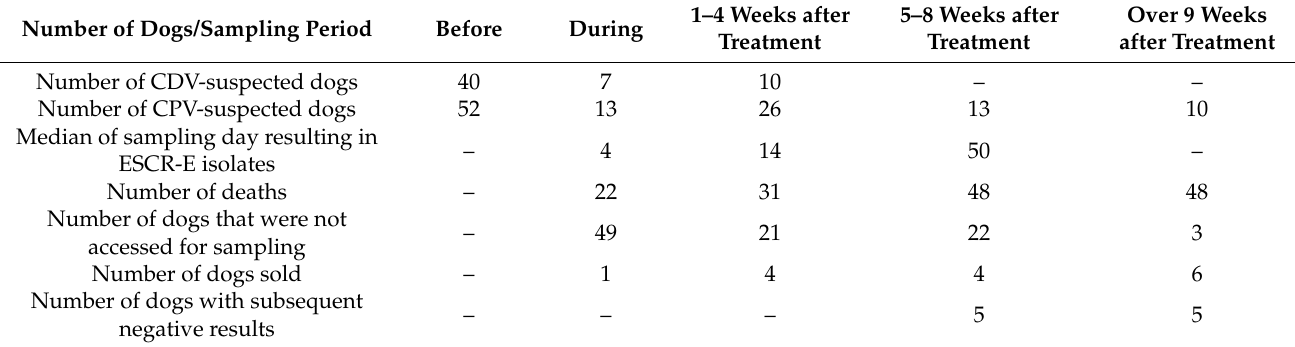
Table 3. Design and sample size of our longitudinal study tracking ESCR-E before and after antibiotic treatment. Number of Dogs/Sampling